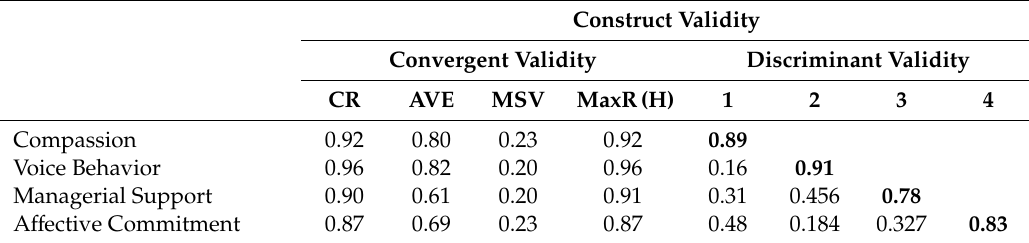
Table 2. Convergent and discriminant